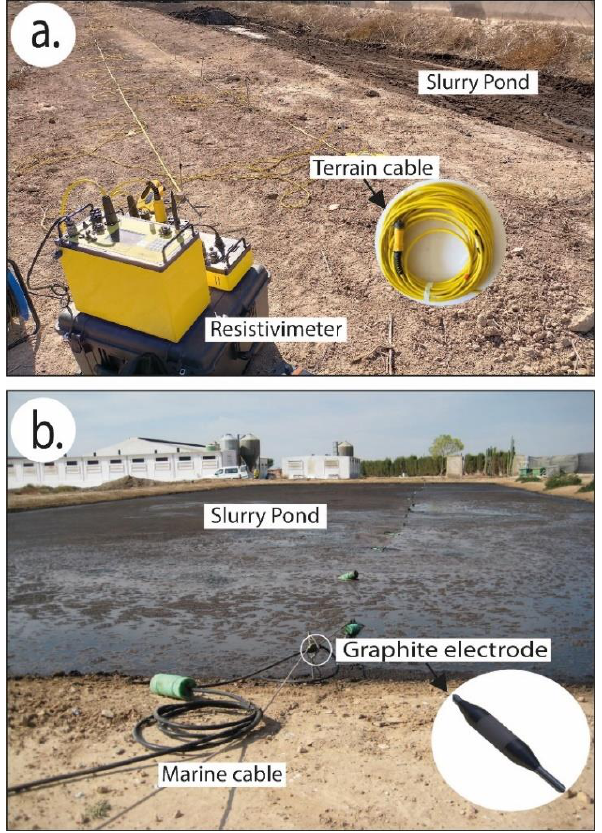
Figure 4. Typical set up of ( a ) an ERT external profile and ( b ) an ERT marine profile. For the subsurface electrical resistivity measurements, a dipole – dipole array was used.